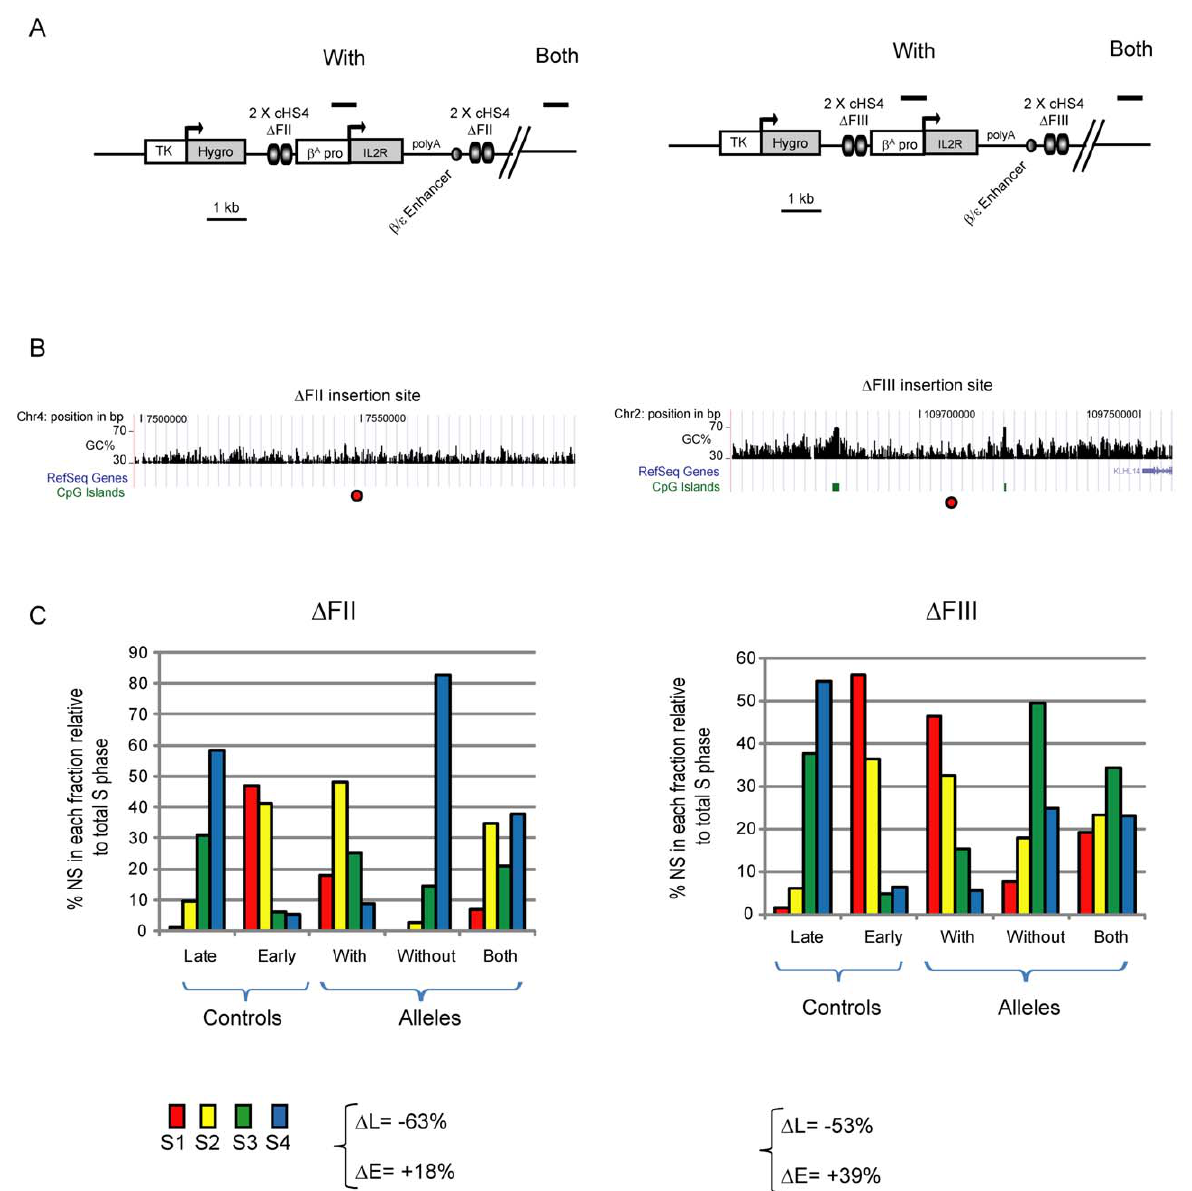
Figure 10. Integration of a transgenic b A replicator flanked by insulators induces early replication timing at two other chromosomal loci. Replication timing profiles following transgene integration into erythroid 6C2 cells. (A) Schematic representation of the IL-2R transgene drawn to scale. The construct is identical to the one described in Figure 5A, except that HS4 carries deletions of the CTCF ( D FII) or VEZF1 ( D FIII) binding sites. This construct is linked to the hygromicin antibiotic resistance gene under the control of the HSV-thymidine kinase promoter. (B) The mapped sites of integration (red dots) for the transgenes flanked by D FII or D FIII insulators are shown. UCSC genome browser views (May 2006 build) of 100 kb regions with the chromosomal position, GC percentage, annotated genes, and CpG islands shown. (C) Replication timing profiles of chromosomal alleles at the mapped sites of transgene integration. Late and early replicated controls correspond to the endogenous amylase a 2A and b -globin loci, respectively. The differences in late or early replication ( D L and D E) at flanking regions compared with the integration site are